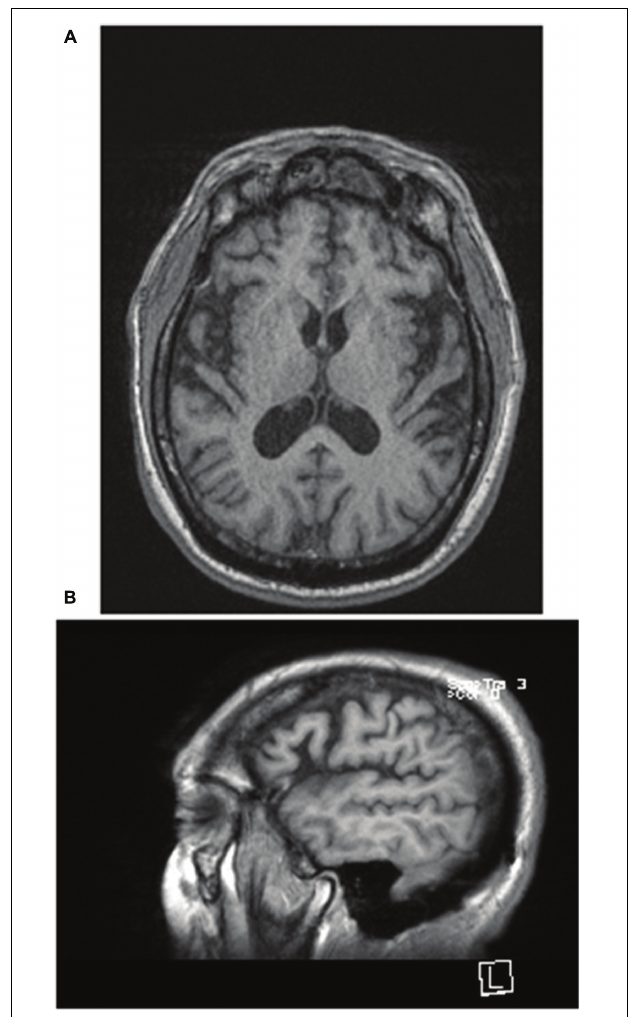
FIGURE 1 | (A) T1 axial and (B) sagittal images of the brain obtained 9 months earlier demonstrate mild global volume loss for age with widening of the Sylvian fissure bilaterally. Neither evidence of past acute TBI nor white matter abnormalities were noted on fluid-attenuated inversion recovery (FLAIR)